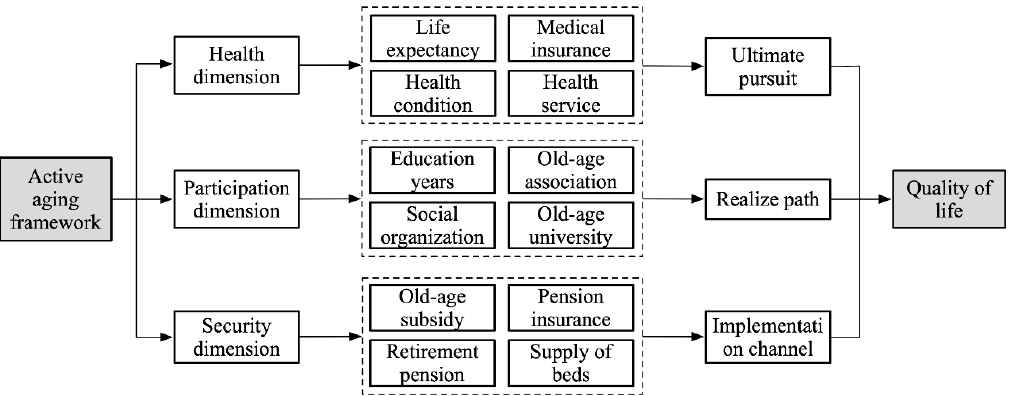
Figure 1. Theoretical framework of quality of life.